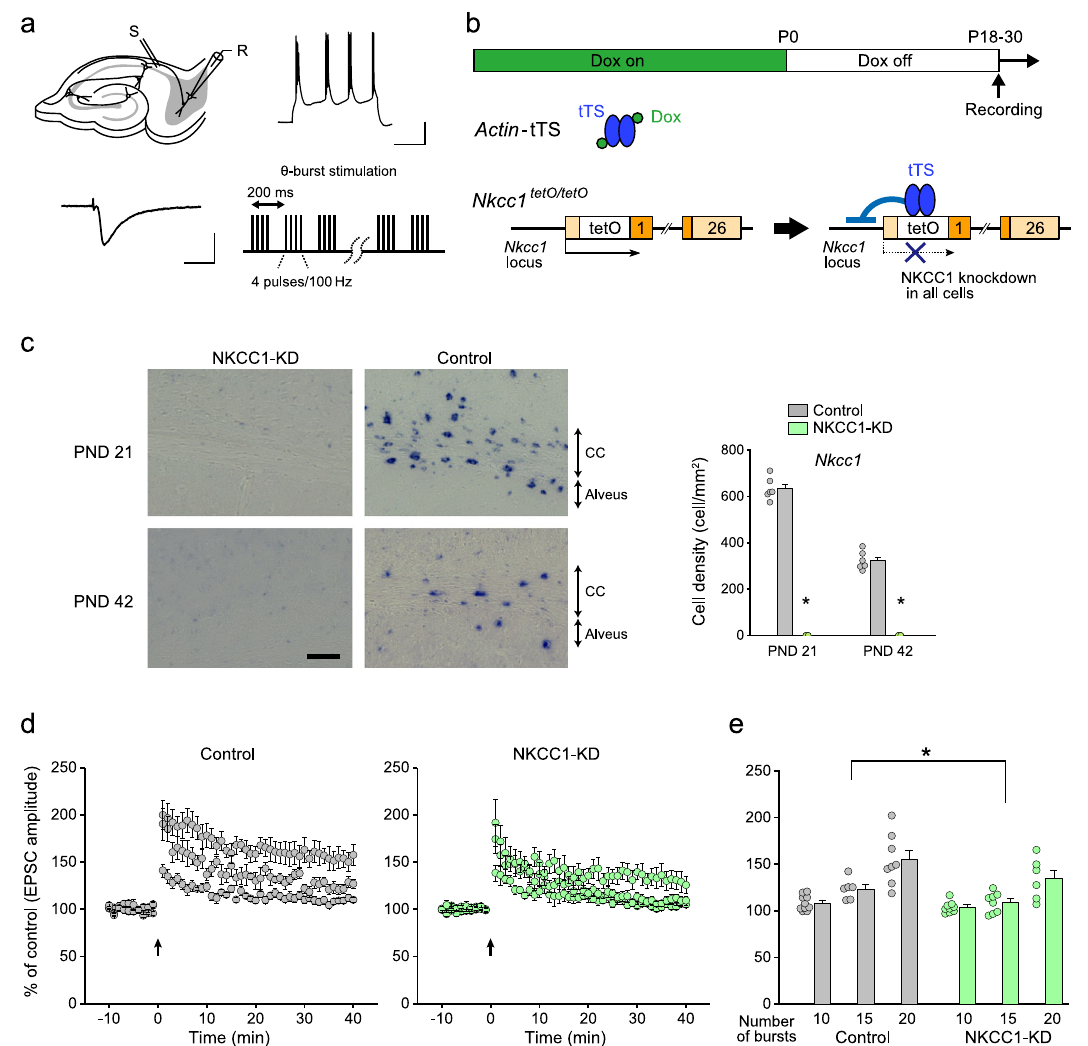
Fig. 5 Nkcc1 loss-of-function attenuates the induction of long-term potentiation. a Recording of excitatory postsynaptic currents (EPSCs) from bursting neurons in the subiculum and electrical stimulation protocol of theta burst stimulation for the induction of long-term potentiation. Scale, 200 ms and 20 mV for fi ring pattern, and 50 ms and 100 pA for EPSC. b Induction of Nkcc1 knockdown (NKCC1-KD) from postnatal day 0 by removing doxycycline (Dox)-containing chow. c In situ hybridization images with an Nkcc1 mRNA probe showing signals in the corpus callosum and alveus at the indicated PND in control mice ( Nkcc1 tetO/tetO ) ( n = 6 slices from 3 animals) and NKCC1-KD mice ( n = 6 slices from 3 animals) at PND 21 and 42. Scale bar, 100 µ m. Cell counts for Nkcc1 -positive cells. Unpaired two-sided Student ’ s t test, PND 21, t 10 = 11.26, P < 0.001; PND 42, t 10 = 8.72, P < 0.001. Data are presented as mean ± SEM. * P < 0.05. d Changes in EPSC amplitude induced by theta burst stimulation with different numbers of bursts in control mice (10 bursts, n = 10; 15 bursts, n = 6; 20 bursts, n = 8, PND 18 – 30) and NKCC1-KD mice (10 bursts, n = 9; 15 bursts, n = 8; 20 bursts, n = 6, PND 19 – 30). Data are presented as mean ± SEM. e Summary histograms for the change in EPSC amplitude at 35 – 40 min after theta burst stimulation. Two-way ANOVA, F (1,41) = 9.80, P = 0.0032. Data are presented as mean ± SEM. * P < 0.05. Source data are provided as a Source Data fi